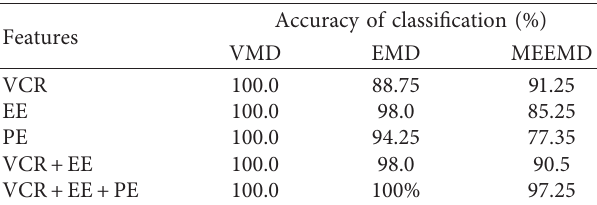
Table 3: The classification results with BP network (2hp).